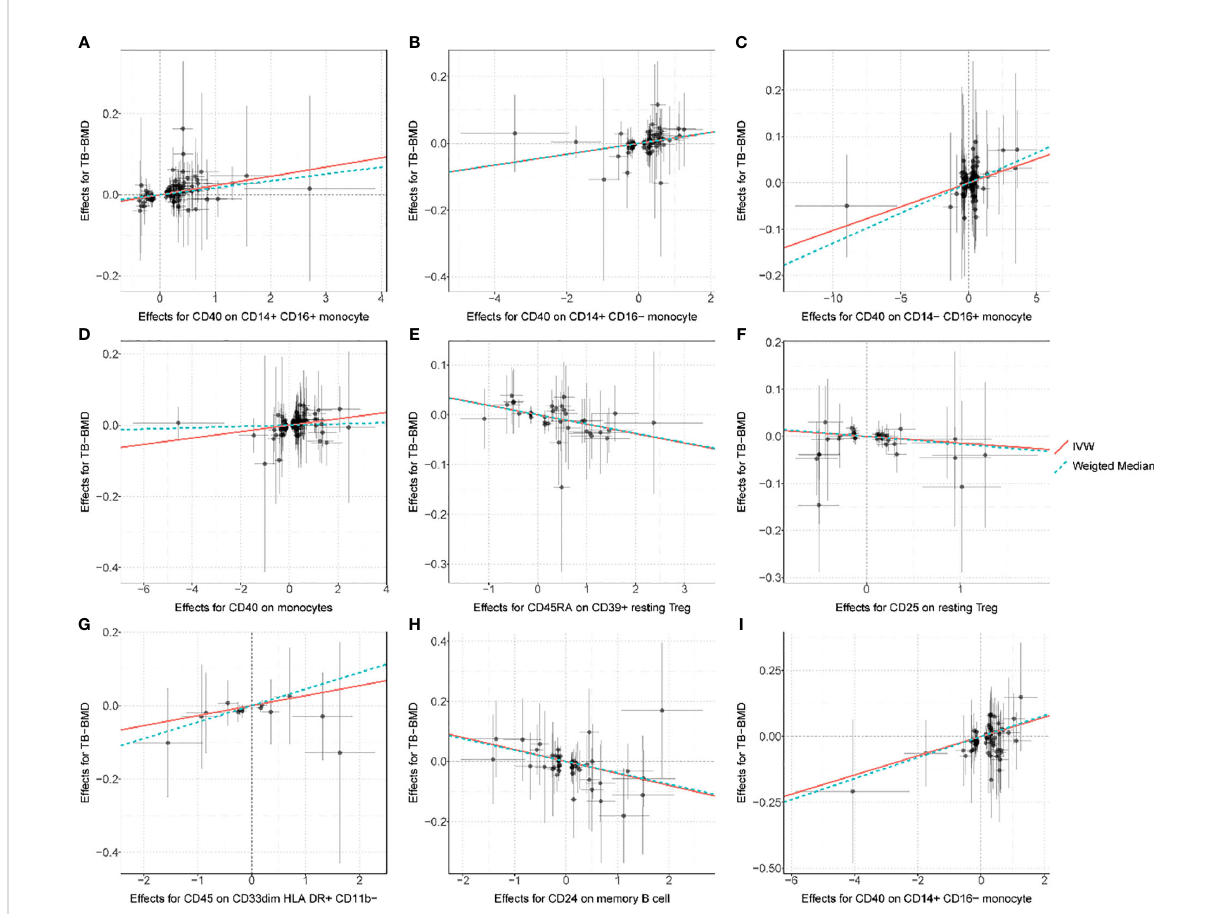
FIGURE 3 Scatter plot for the relationship between the SNP effect size of causal immune traits (x-axis) and the corresponding effect size estimates of BMDs (y-axis). (A) CD40 on CD14 + CD16 + monocyte on TB-BMD. (B) CD40 on CD14 + CD16 − monocyte on TB-BMD, (C) CD40 on CD14 − CD16 + monocyte on TB-BMD, (D) CD40 on monocytes on TB-BMD, (E) CD45RA on CD39 + resting Treg on TB-BMD, (F) CD25 on resting Treg on TB-BMD, (G) CD45 on CD33dim HLA DR + CD11b − on TB-BMD, (H) CD24 on memory B cell on FA-BMD, (I) CD40 on CD14 + CD16 − monocyte on FA-BMD. TB, total body; FA, forearm; BMD, bone mineral